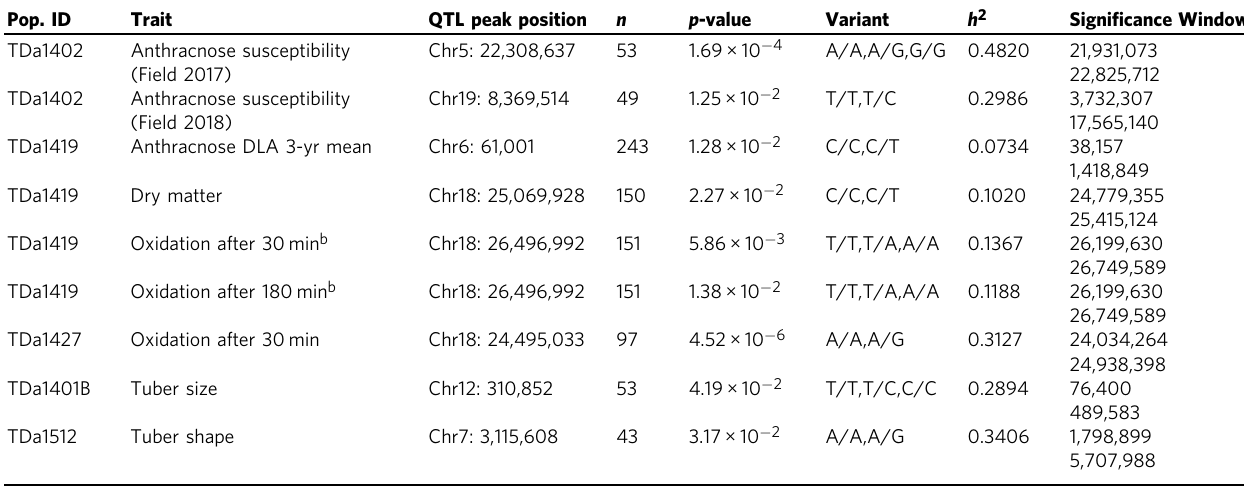
Table 3 Signi fi cant QTL identi fi ed in this